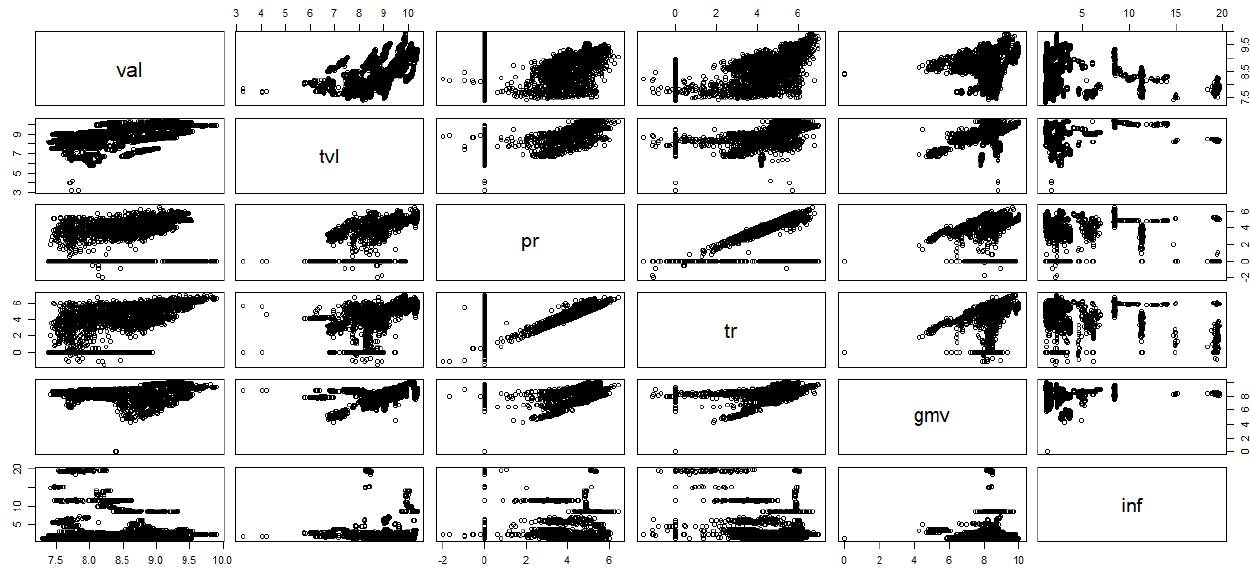
Figure 4. Pairwise Correlations for the Variables Used in the Study. Source: own elaboration in R-Studio.